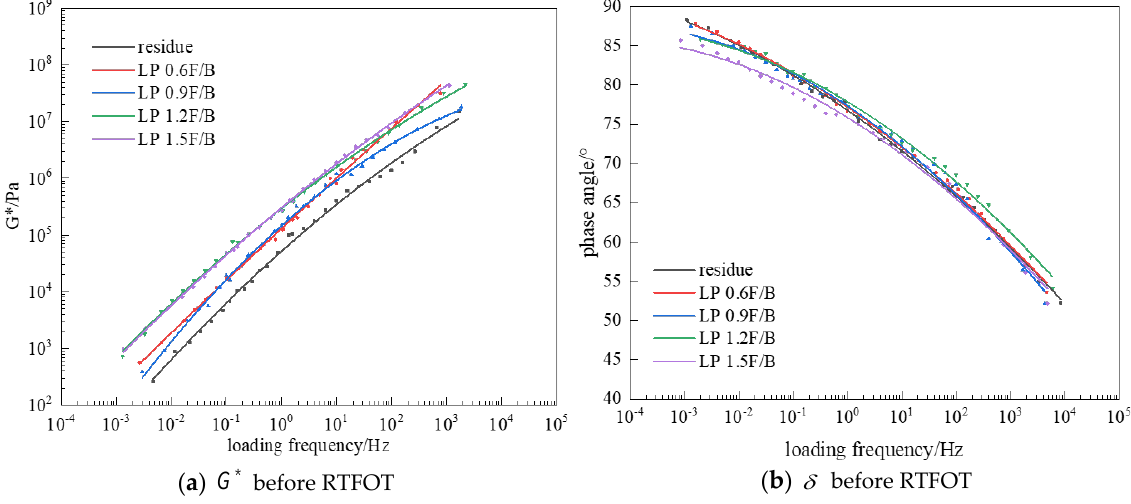
Figure 8. Frequency sweep test results of limestone powder emulsified asphalt mastics.